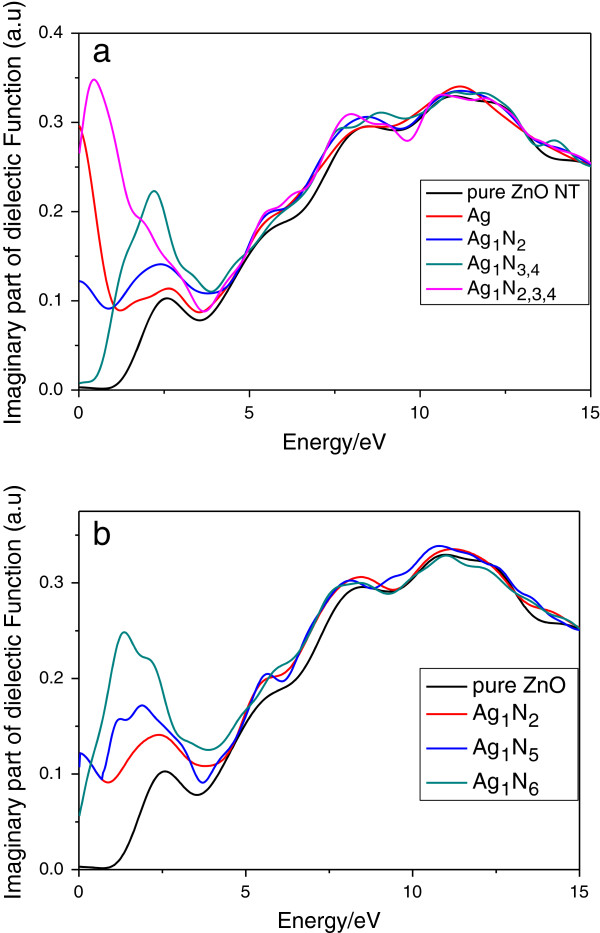
Dielectric function spectra of pure and Ag-N-codoped (8,0) ZnO nanotubes. (a) Configurations of Ag1, Ag1N2, Ag1N2,3,4, and Ag1N3,4. (b) Configurations of Ag1N2, Ag1N5, and Ag1N6.